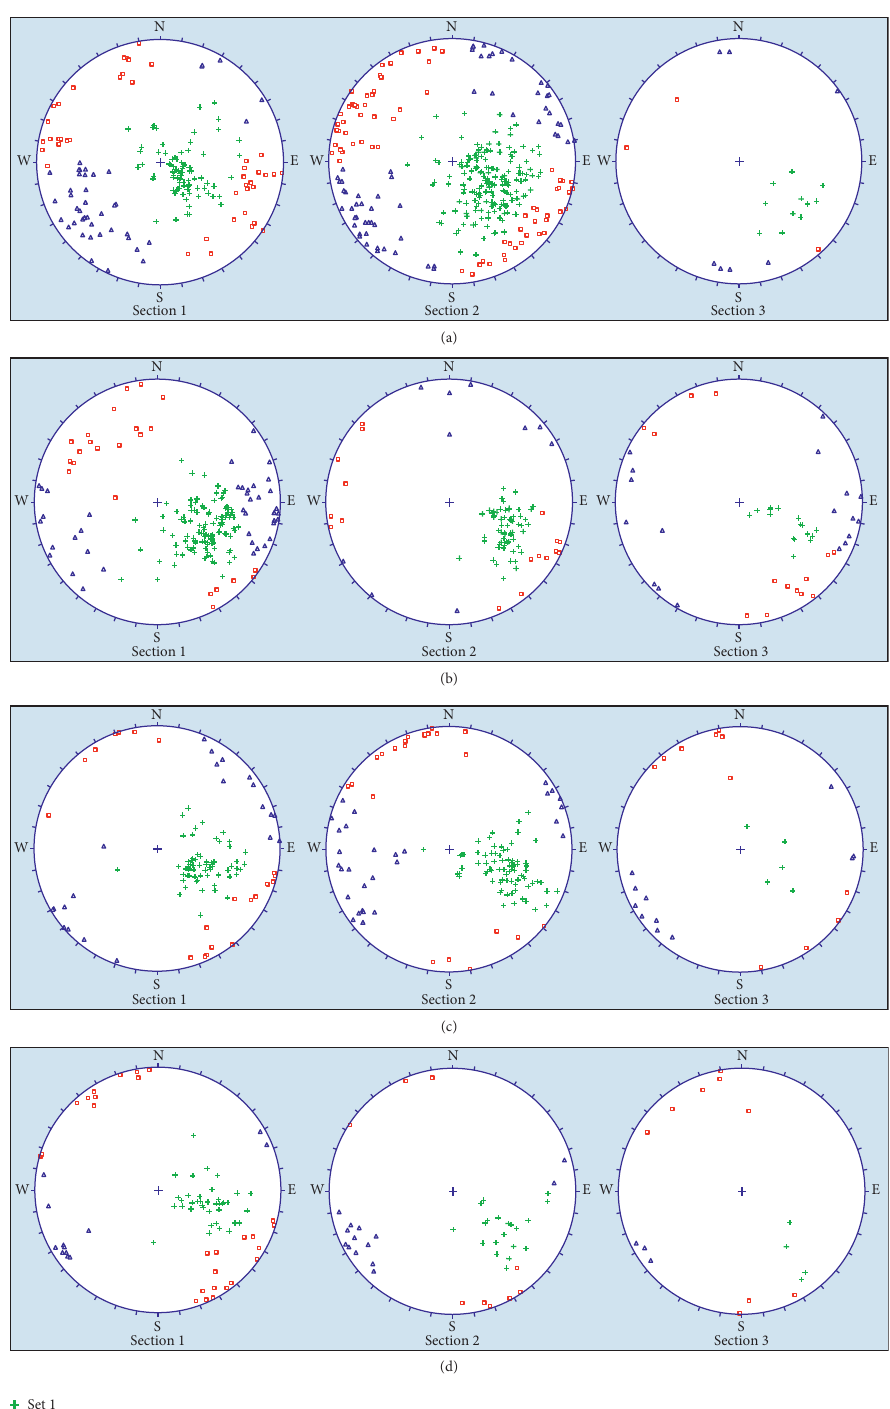
Figure 6: The dominant joint sets of each section in each adit. (a) PDS1. (b) PD222. (c) PD224. (d)